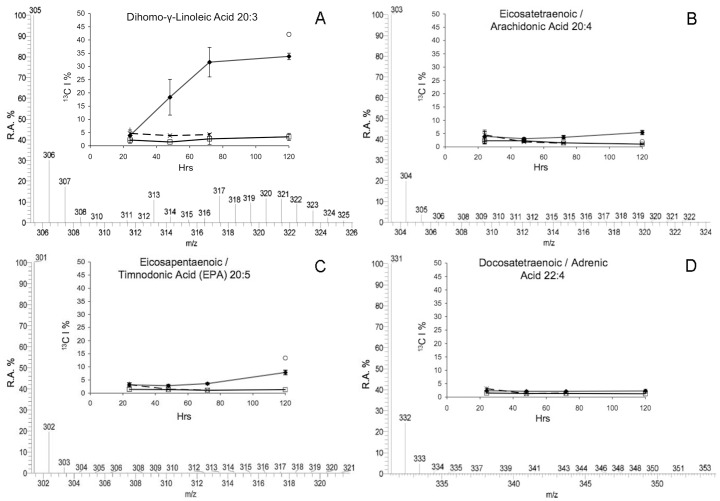
See
Figure 2
 legend.